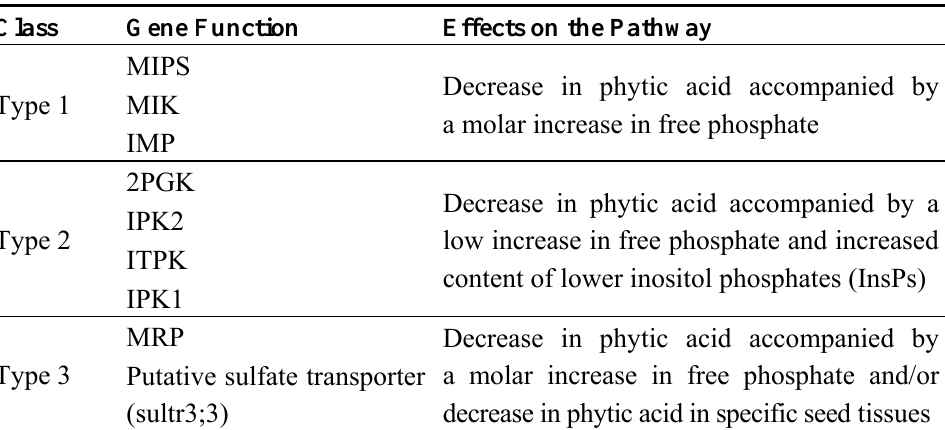
Table 1. Classification of lpa mutations on the basis of the affected function in the pathway for phytic acid synthesis and